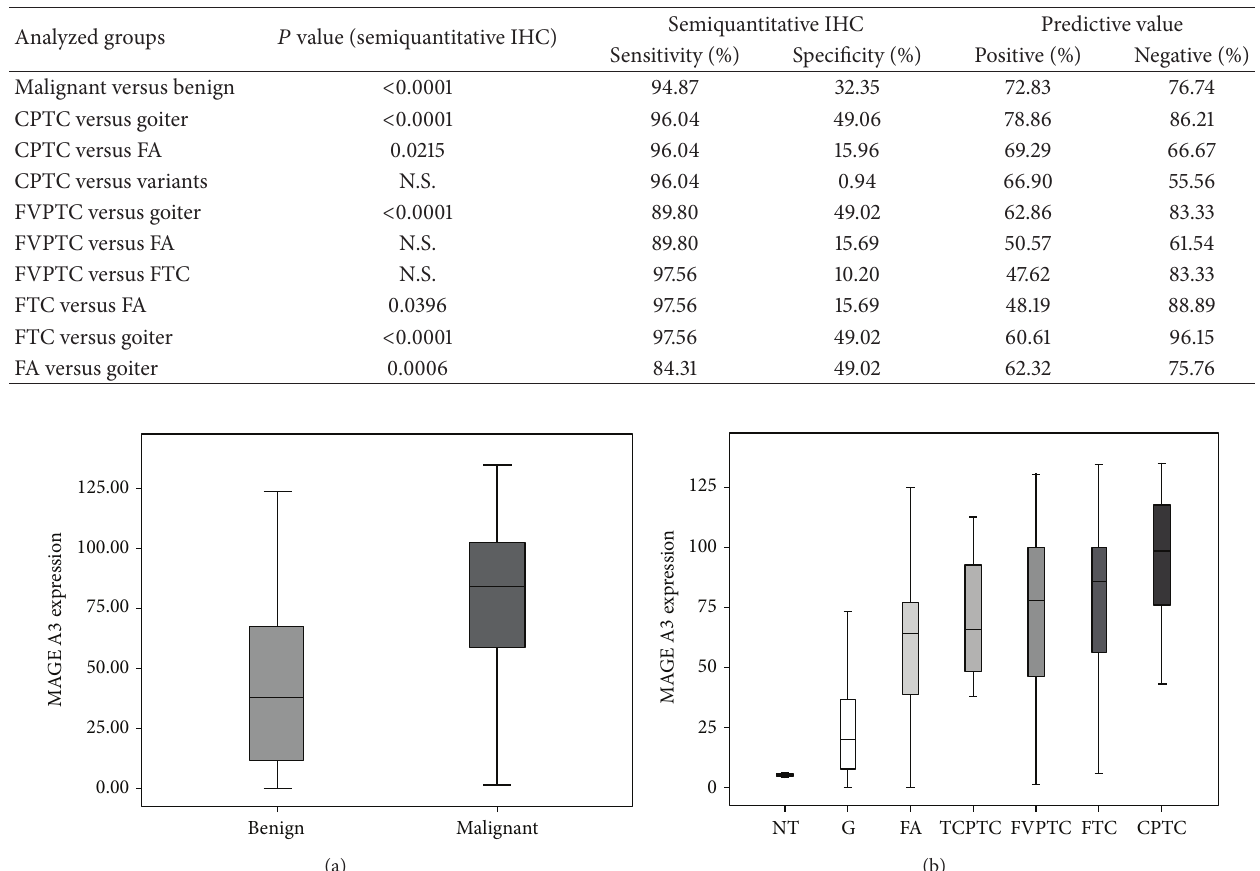
Figure 3: IHC quantitative analysis showing different staining between benign and malignant groups. (a) MAGE A3 immunohistochemical expression in benign and malignant thyroid tissues ( 𝑃 < 0.001 ). (b) MAGE A3 immunohistochemical expression in benign and malignant subtypes of thyroid